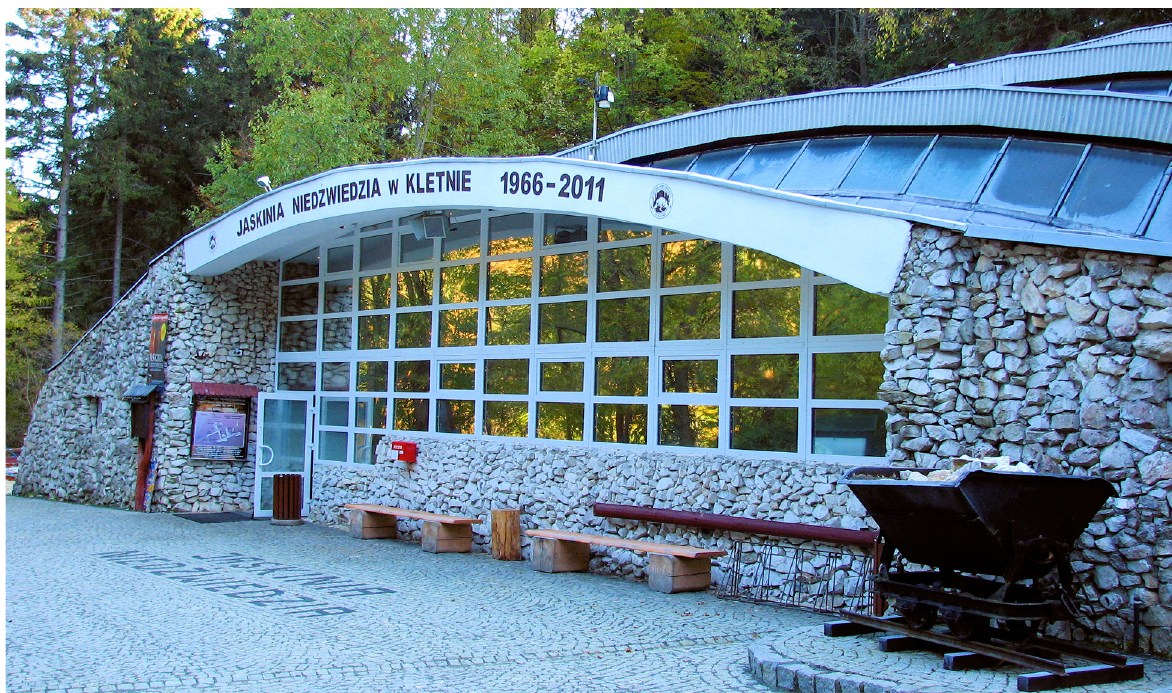
Fig. 4. Entrance pavilion of Bear Cave (photo A.Marek 2021).